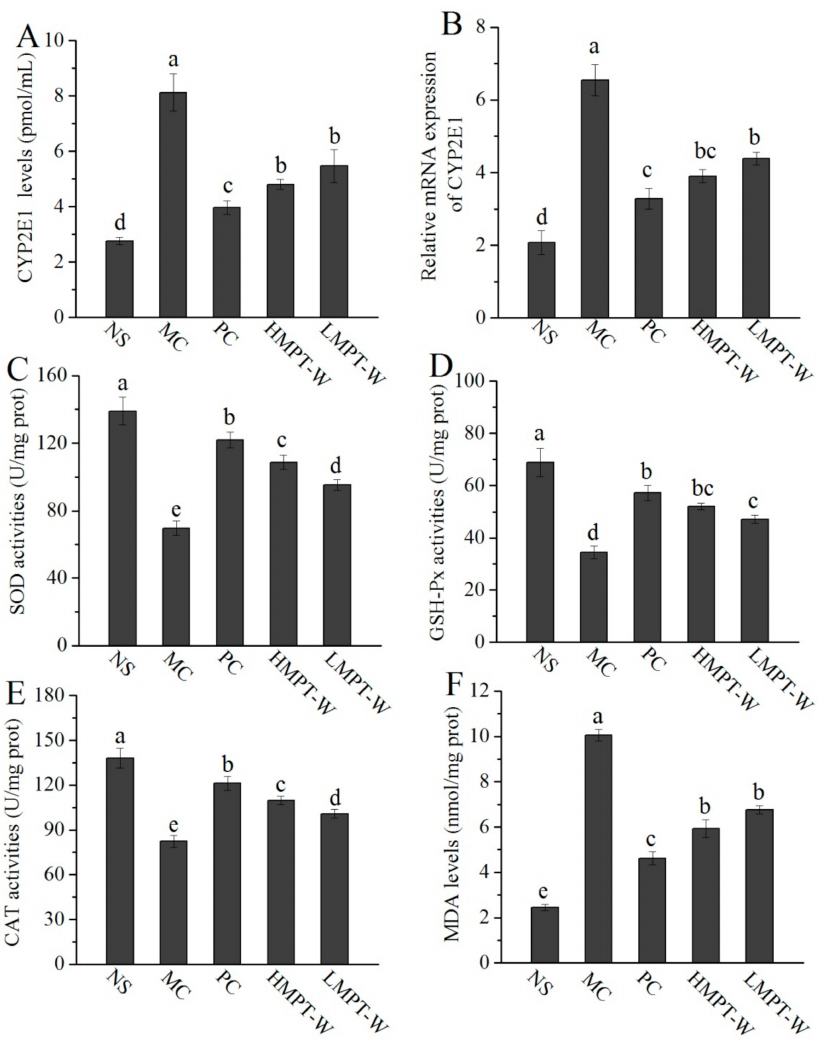
Figure 4. E ff ect of MPT-W on hepatic CYP2E1, antioxidant enzymes and MDA in CCl 4 -induced chronic liver injury mice. ( A ) and ( B ) CYP2E1; ( C ) SOD; ( D ) GSH-Px; ( E ) CAT; ( F ) MDA. The values are reported as means ± SD. Bars with di ff erent letters (a, b, c, d, e) are significantly di ff erent ( p < 0.05). CYP2E1: cytochrome P4502E1, MDA: malondialdehyde, SOD: superoxide dismutase, GSH-Px: GSH peroxide, CAT: